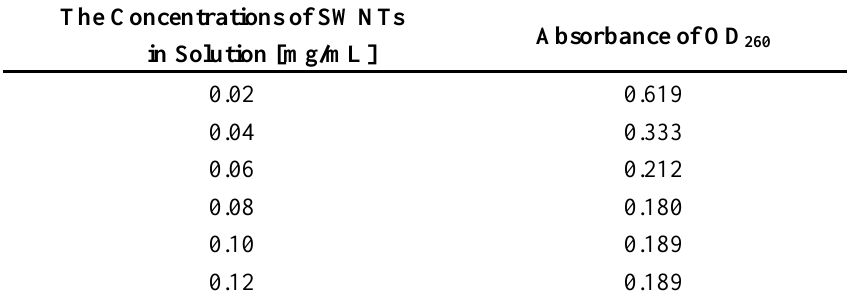
Table 2. The absorbance of the working solution containing probe P0 (500 nM) and different concentrations of SWNTs during the incubation